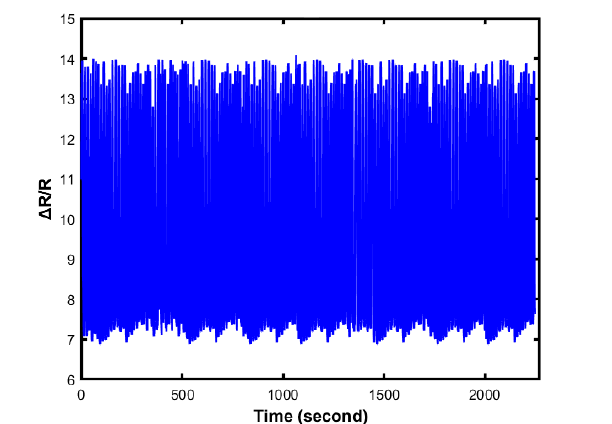
Figure 10. One thousand episodes of cyclic loading and unloading tests at 30 kPa for 6